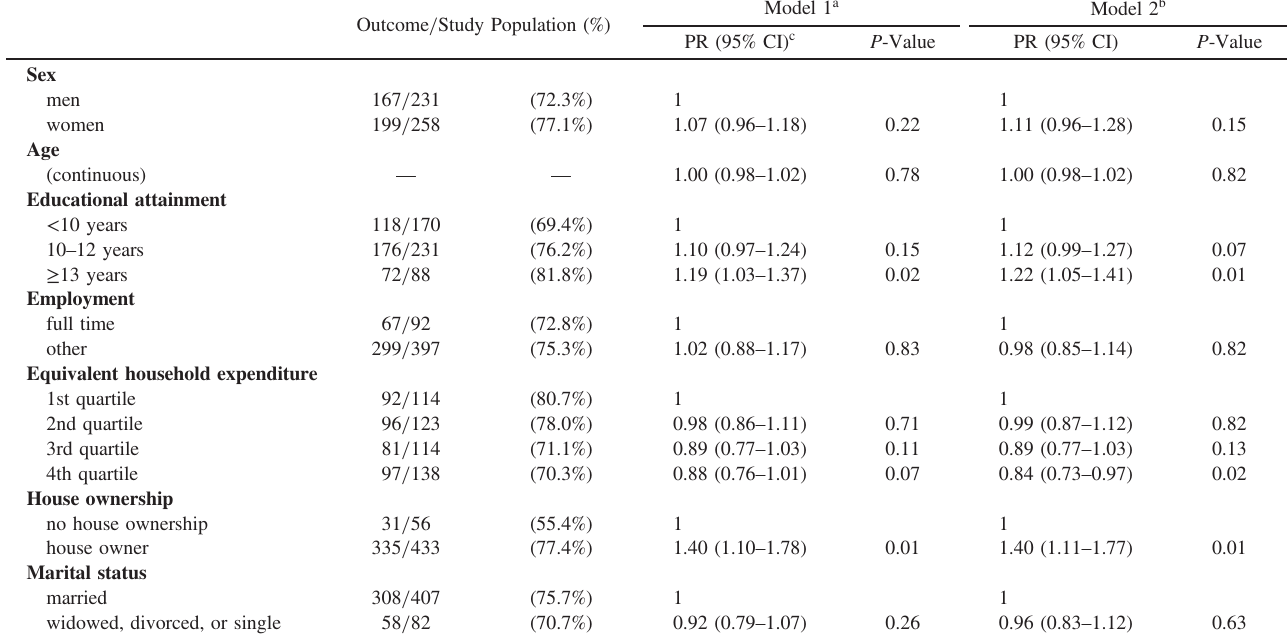
Table 3. Relationships among participation in health examinations and related factors in the 65 – 74 years group: NIPPON DATA2010